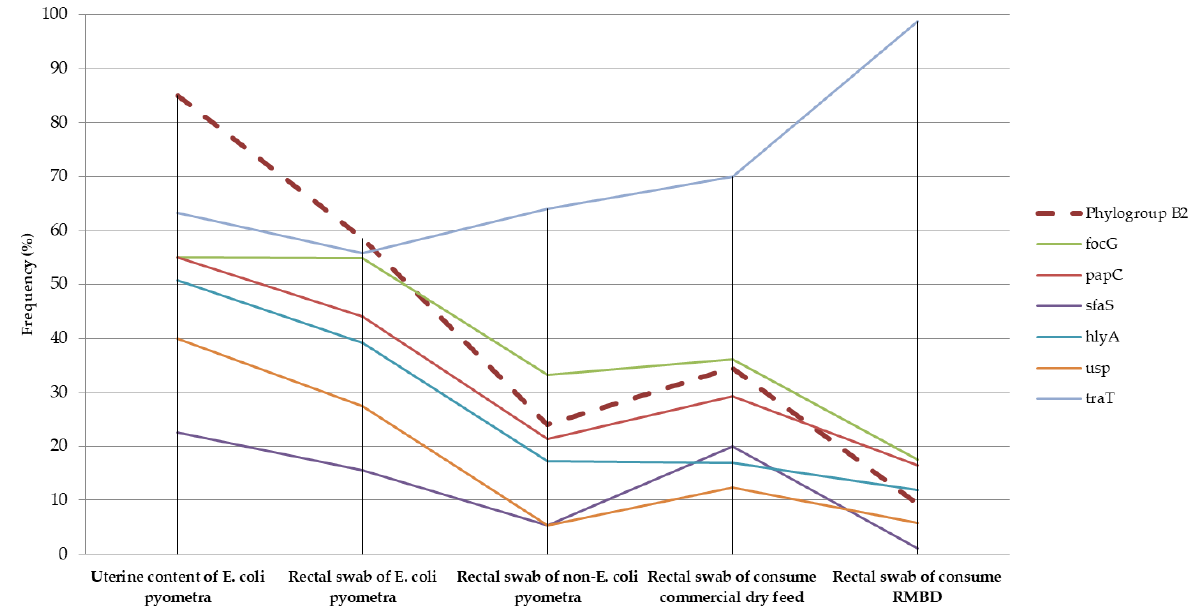
Figure 1. Frequency of the phylogroup B2 and the main virulence factors identified in E. coli isolated from the uterine content, rectal swabs of bitches with pyometra and rectal swabs of healthy dogs fed commercial dry feed and raw meat-based diet (RMBD).